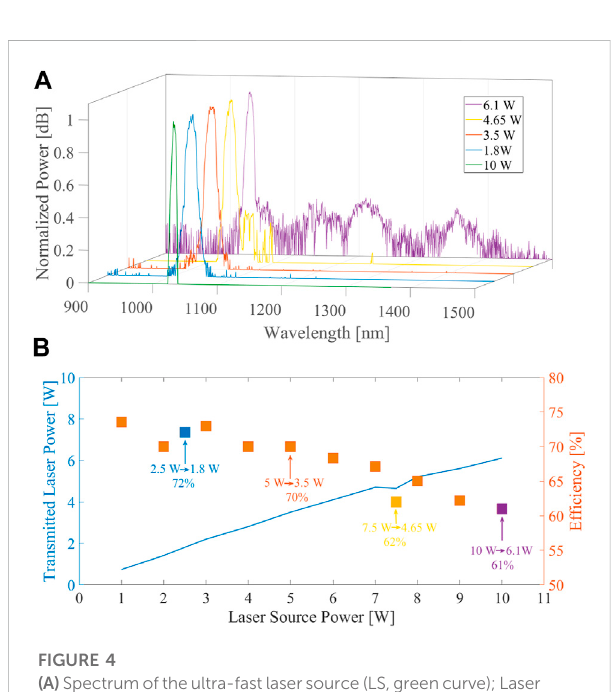
FIGURE 4 (A) Spectrumoftheultra-fastlasersource(LS,greencurve);Laser transmitted spectra measured after the air- fi lled AR-HCF: After transmissions, the input laser power drops from 2.5 W to 1.8 W (blue curve), 5 W – 3.5 W (orange curve), 7.5 W – 4.65 W (yellow curve) and 10 W – 6.1 W (purple curve), respectively. (B) Transmitted laser power and transmission ef fi ciency versus ultra-fast laser source